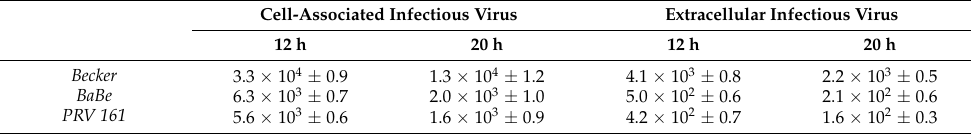
Table 3. Infectious virus produced by hippocampal neurons infected with PRV mutants . Cell-Associated Infectious